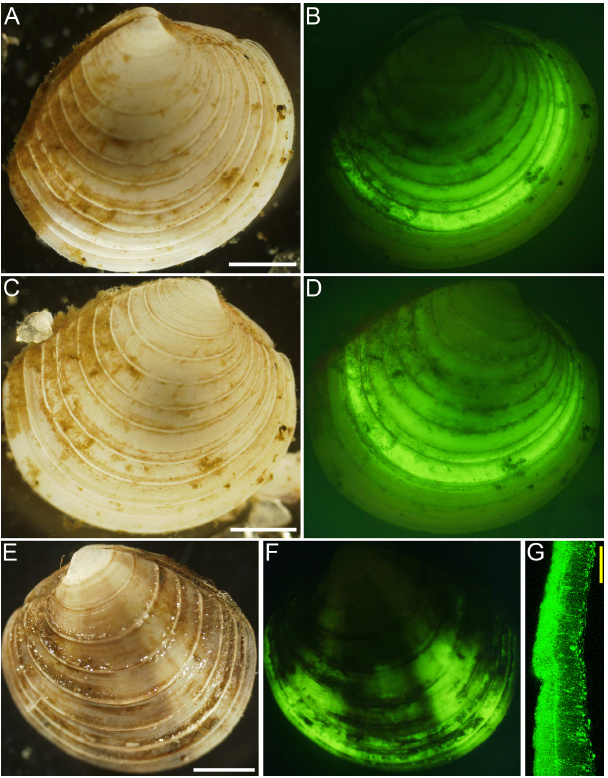
Figure 2. Paired micrographs of quahogs after calcein osmotic pump incubations. Reflected (a, c, e) and epifluorescence (b, d, f) images of quahogs after short bleach and air drying ( e was not com- pletely dry). Note calcein banding in valves. In (f) calcein extends to the edge of the valve because this specimen died during the experi- ment. (g) CLSM micrograph showing cross section of specimen e , f valve after thorough bleaching. Scales: a , c , e = 2mm; g =